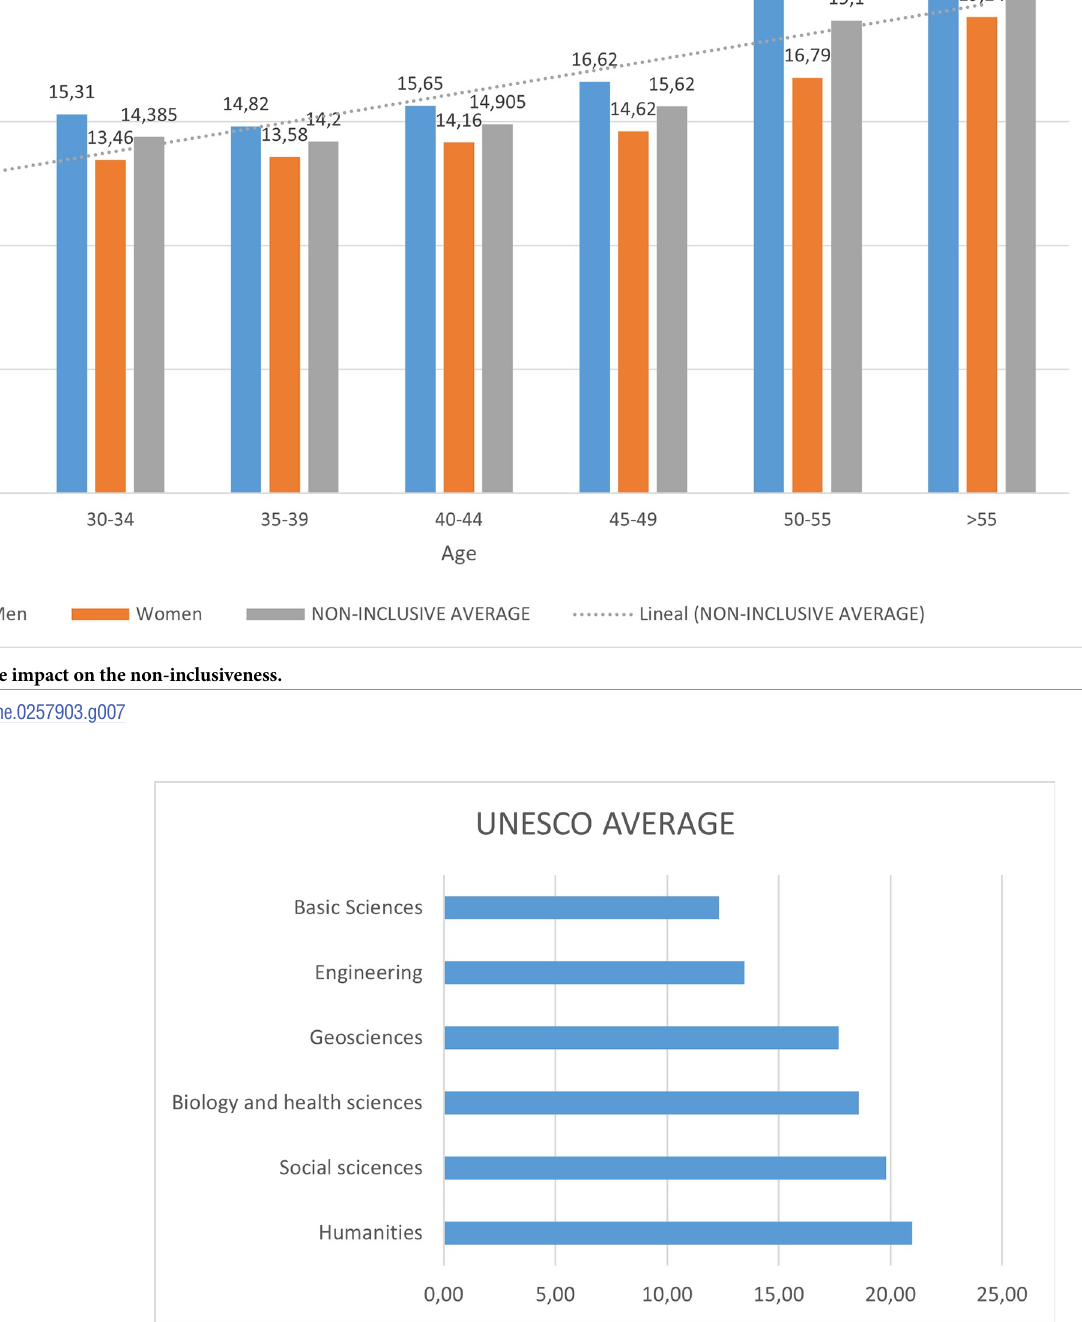
PLOS ONE | https://doi.org/10.1371/journal.pone.0257903 September 30,